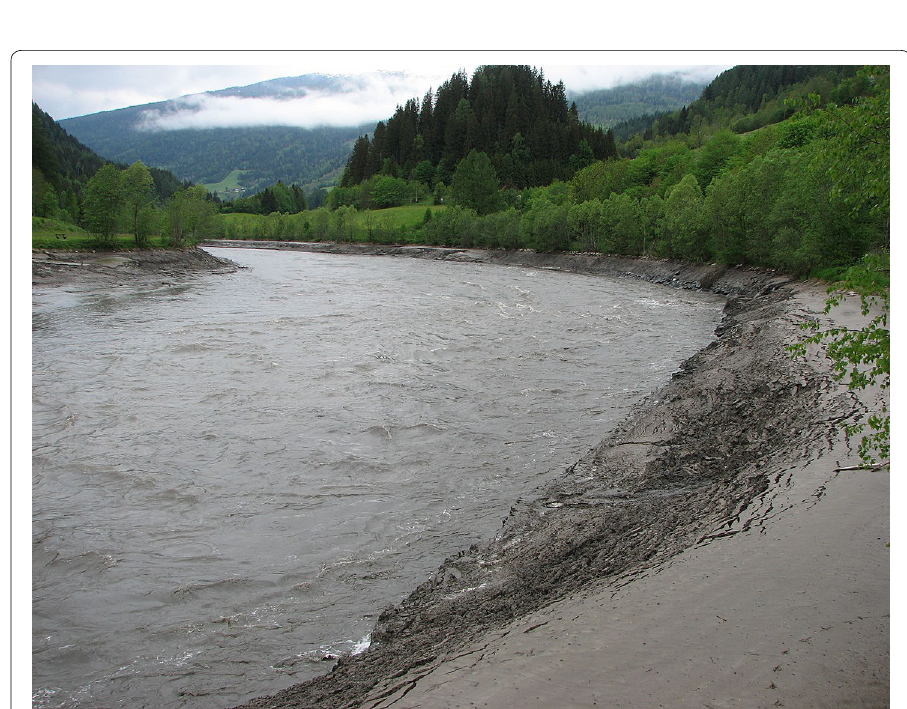
Fig. 13 Photograph of a bank of the Bodendorf reservoir during